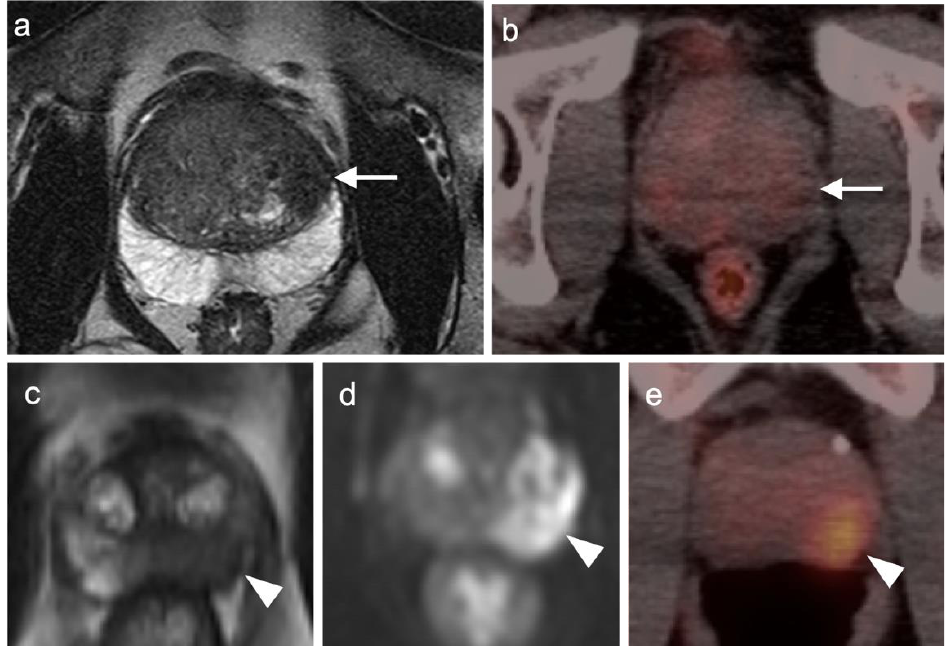
Figure 21. Two patients with prostate cancer on axial MRI and FDG PET-CT images of the pelvis. Case 1: ( a ) Well-differentiated prostate cancer (Grade group 2) shows typical low signal on T2 MRI in the peripheral zone of the left lobe of the prostate (white arrow); ( b ) FDG PET-CT in this patient is negative in the region of tumor (white arrow) but shows mild diffuse uptake typical for benign prostatic hypertrophy (BPH); Case 2: ( c ) T2 MRI in a patient with more poorly differentiated prostate cancer (Grade group 4) shows typical low signal intensity in a tumor in the peripheral zone of the left lobe of the prostate (white arrow); ( d ) DWI MRI shows increased signal intensity in the prostate cancer (white arrowhead); ( e ) FDG PET-CT shows increased metabolic activity in the prostate cancer (white arrowhead).